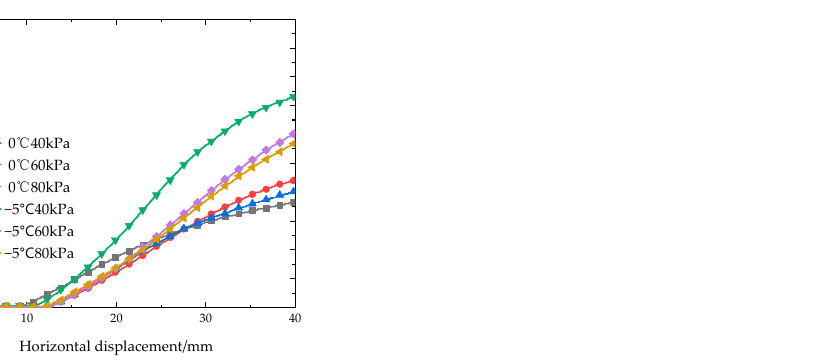
Figure 15. The relationship between horizontal and normal displacement of reinforced soil composite under different normal stress during shear process.